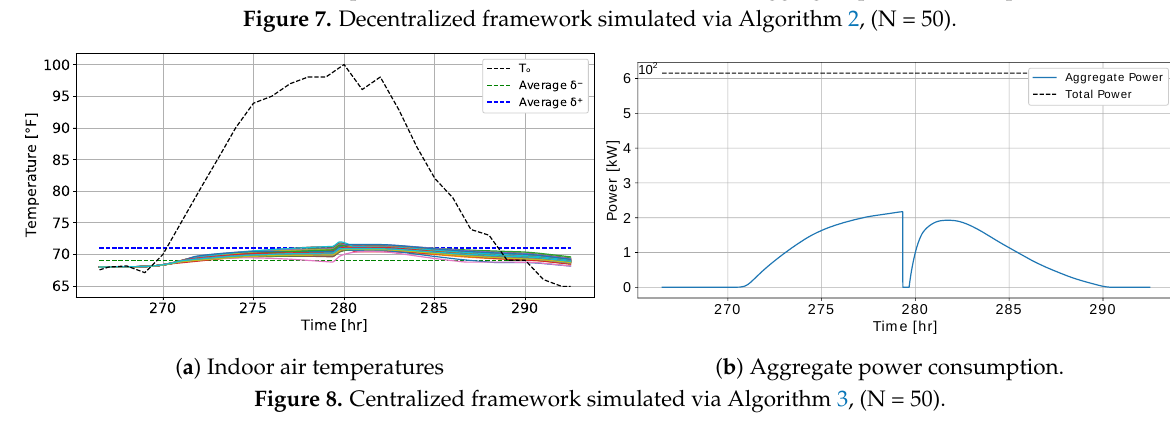
Figure 7. Decentralized framework simulated via Algorithm 2, (N = 50).